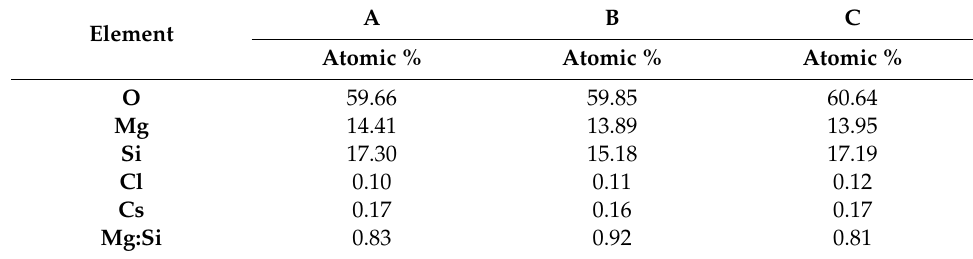
Table 3. Energy-dispersive X-ray spectroscopy (XDS) results of the M–S–H system-solidified body with 1.6 wt %